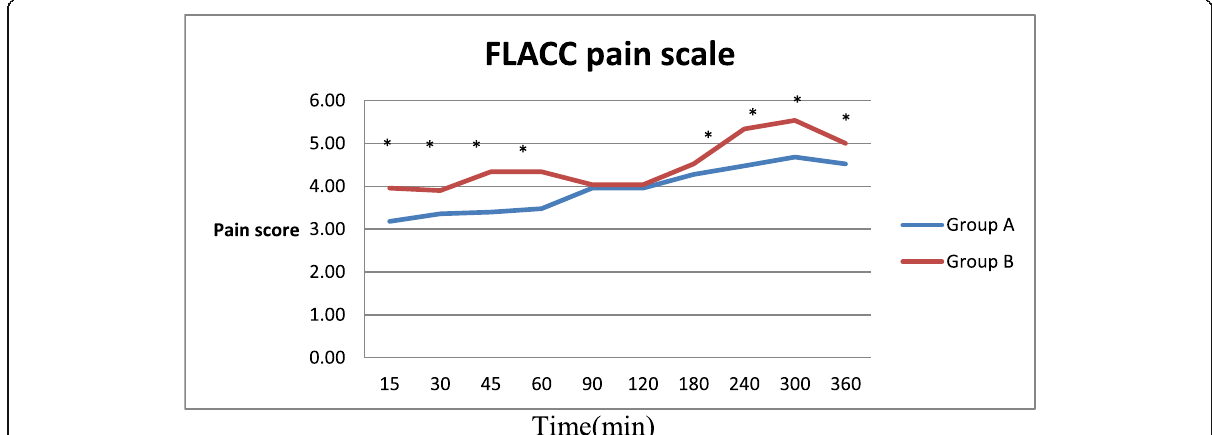
Fig. 1 FLACC (Face, Legs, Activity, Cry, and Consolability) pain scale 6h postoperatively in both groups. Data were expressed as mean±SD. * P